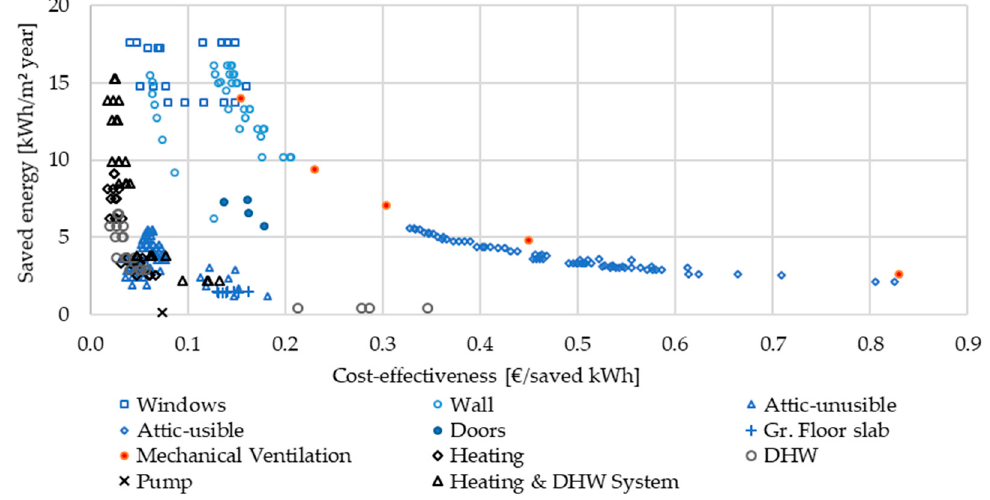
Figure 4. Cost-effectiveness of single renovation actions investigated for the Danish case study Figure 4. Cost-e ff ectiveness of single renovation actions investigated for the Danish case study building.